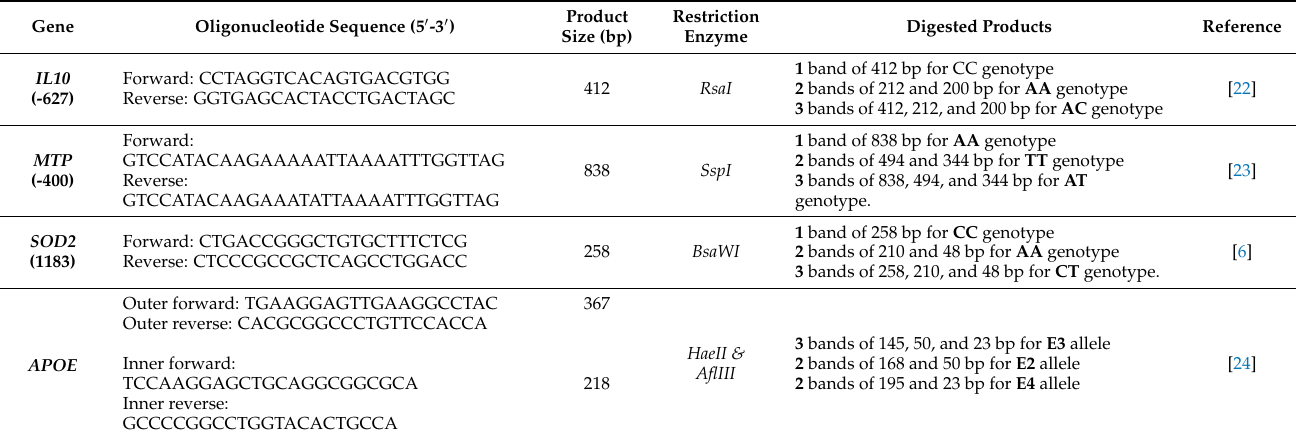
Table 1. Primer sequences, enzymes used, and digested products obtained for detection of IL-10 , MTP , SOD2 , and APOE gene polymorphisms by polymerase chain reaction-restriction fragment length polymorphism (PCR-RFLP). Gene Oligonucleotide Sequence (5 (cid:48) -3 (cid:48) ) Product Size (bp) Restriction Enzyme Digested Products